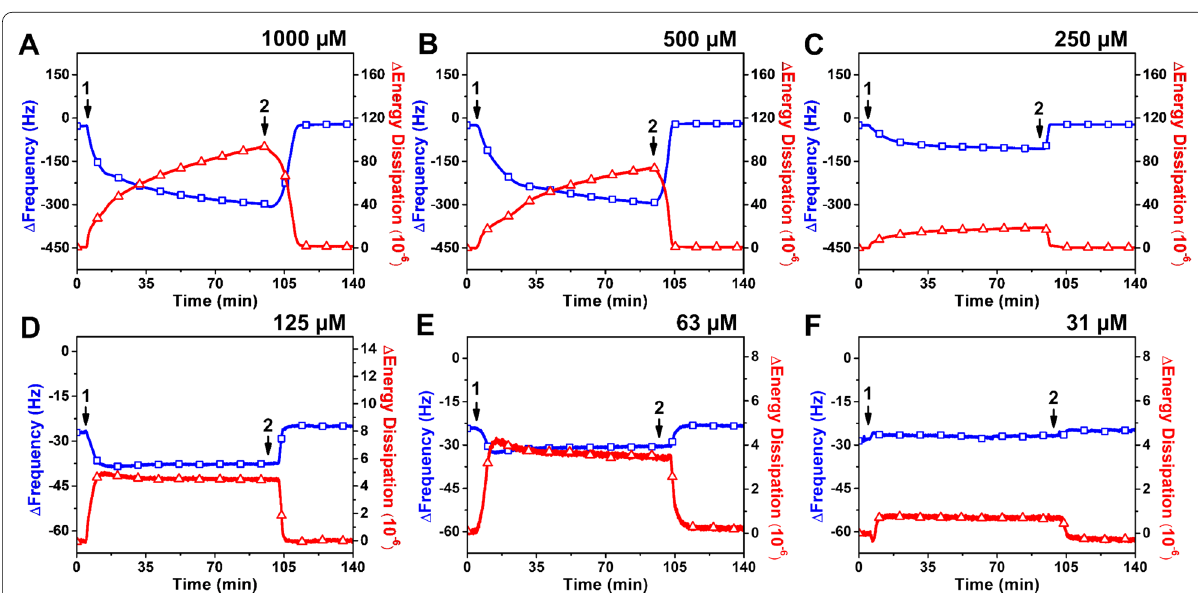
Fig. 4 QCM‑D tracking of monoundecanoin addition to supported lipid bilayer platform. Time‑resolved Δ f (blue line with squares) and Δ D (red line with triangles) shifts are presented for treating the SLB with ( A ) 1000 µM, ( B ) 500 µM, ( C ) 250 µM, ( D ) 125 µM, ( E ) 63 µM, and ( F ) 31 µM monoundecanoin. The initial baseline measurements were consistent with the typical QCM‑D values for supported lipid bilayer formation on a silica surface. After the baseline signals were stabilized for 5 min, monoundecanoin was continually added (arrow 1) for around 90 min before a buffer washing step was performed (arrow